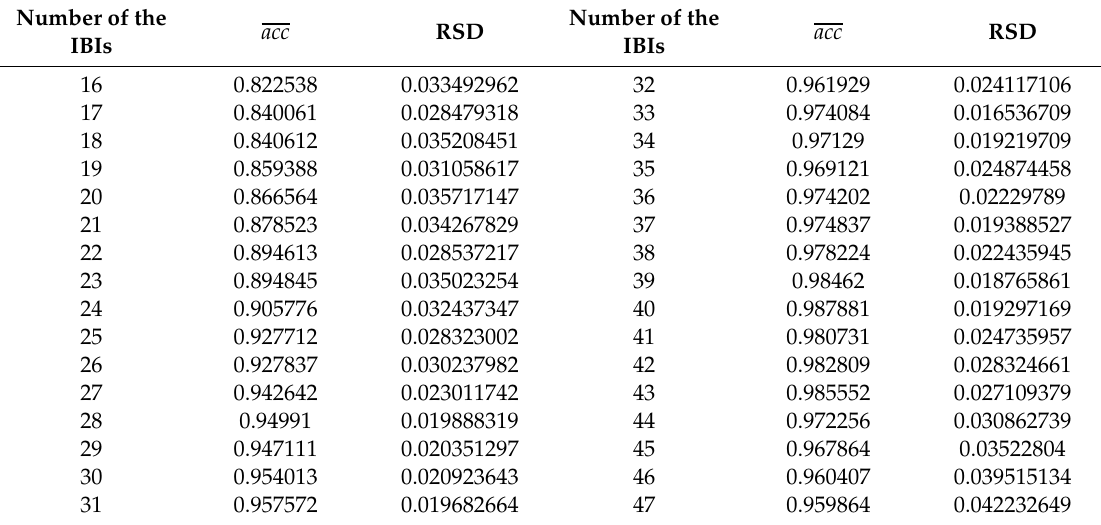
Table 1. Performance on the CNN model for di ff erent data sets created with the pictures of di ff erent number of IBIs.